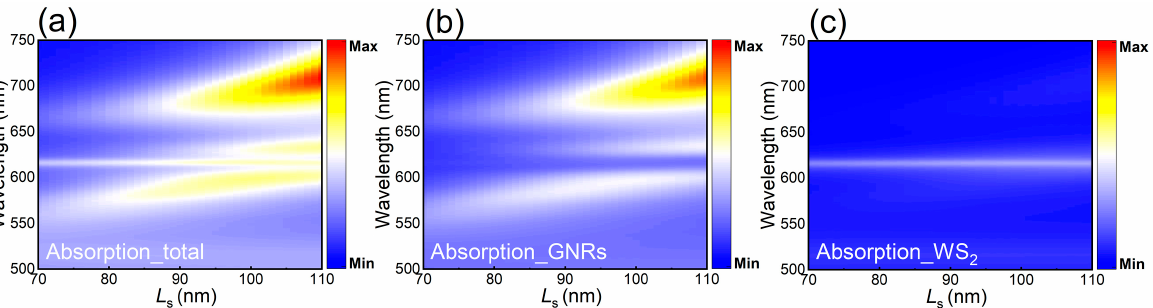
Figure 6. ( a ) Two-dimensional absorption spectrum calculated for a T-shaped GNR dimer with variant length of the short GNR placed on a WS 2 monolayer. ( b ) Two-dimensional absorption spectrum calculated for a T-shaped GNR dimer with variant length of the short GNR. ( c ) Two-dimensional absorption spectrum obtained by subtracting the spectrum shown in ( b ) from that shown in ( a ).